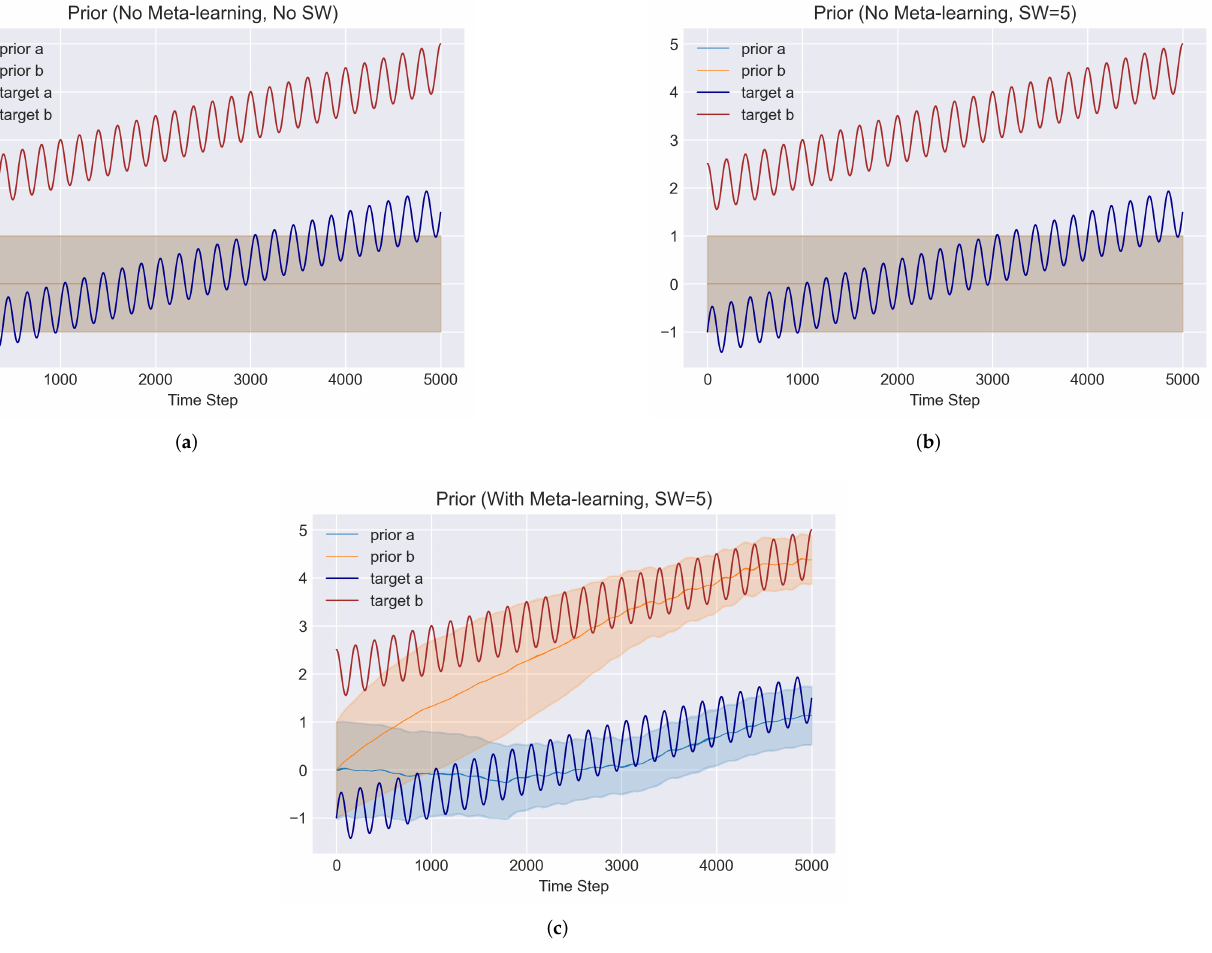
Figure 4. Prior distributions for parameters a and b over time steps. The dark blue and red lines are for the true a and b values. The light blue and orange lines are for the mean of the prior distributions, and shaded areas are for the std. range. ( a ) No meta-learning, no sliding window; ( b ) no meta-learning, sliding window = 5; ( c ) meta-learning, sliding window =